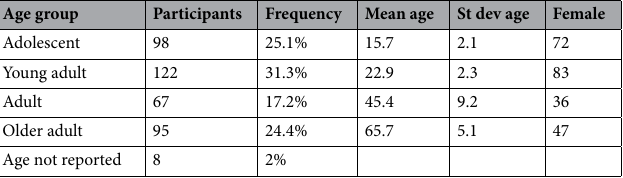
Table 14. Age group frequency and number of participants.